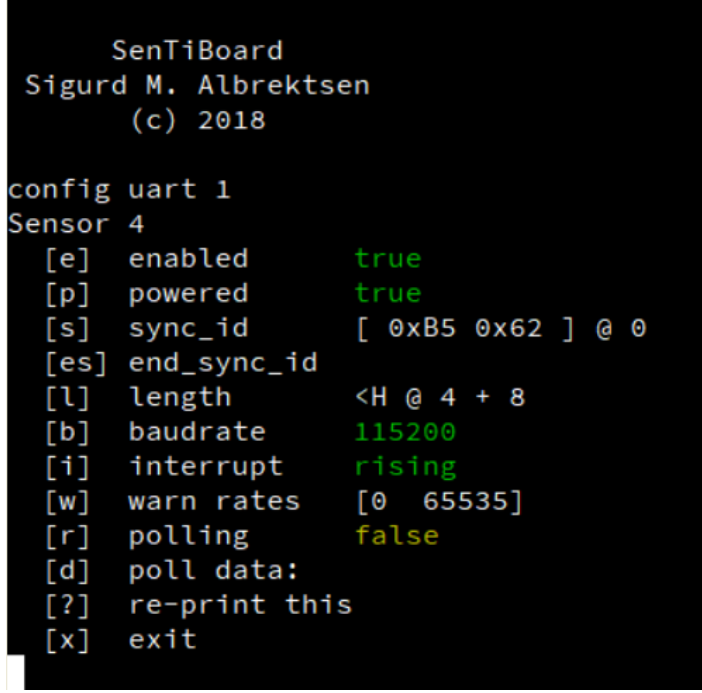
Figure 7. An example of a CLI for sensor port